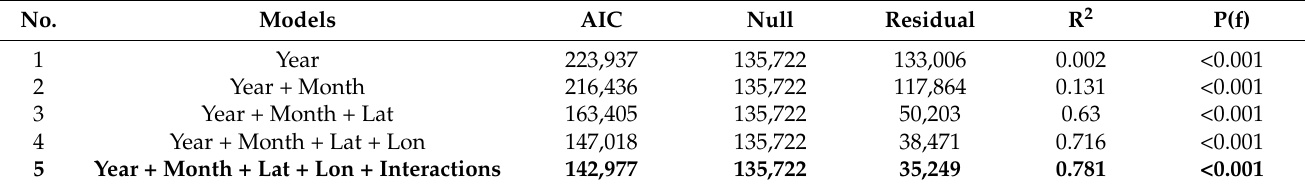
Table 2. Performance of various combinations of generalized linear models for the standardization of immature albacore nominal